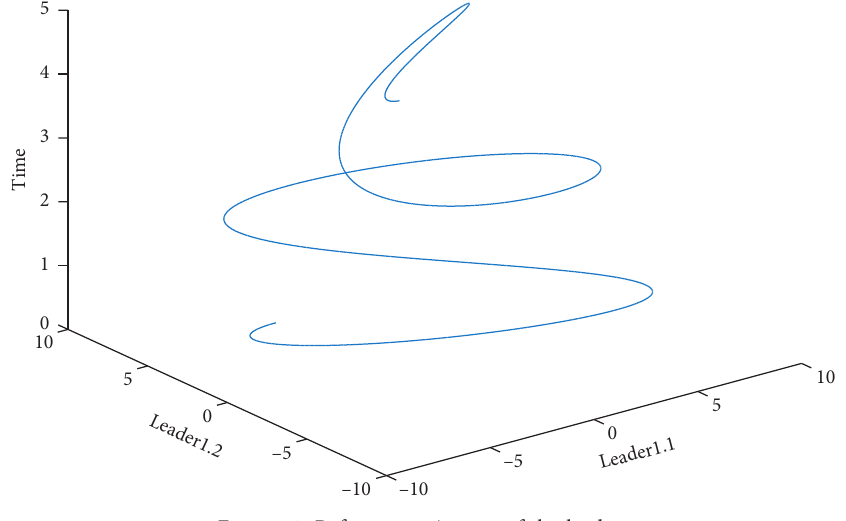
Figure 1: Reference trajectory of the leader.